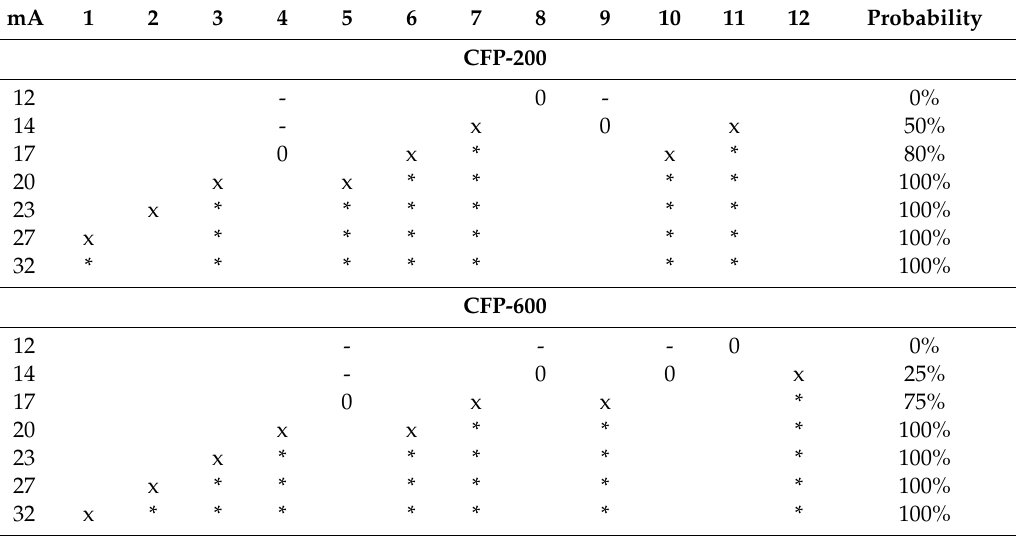
Each vertical column represents the results for one rat from the corresponding group. “x”—tonic hind